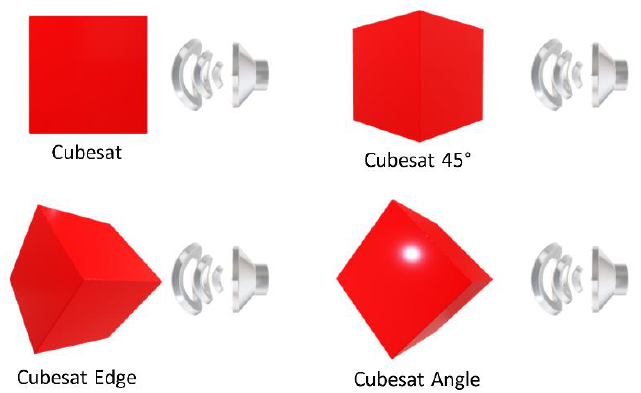
Figure 2. Cubesat positioning in respect to wave incidence direction.